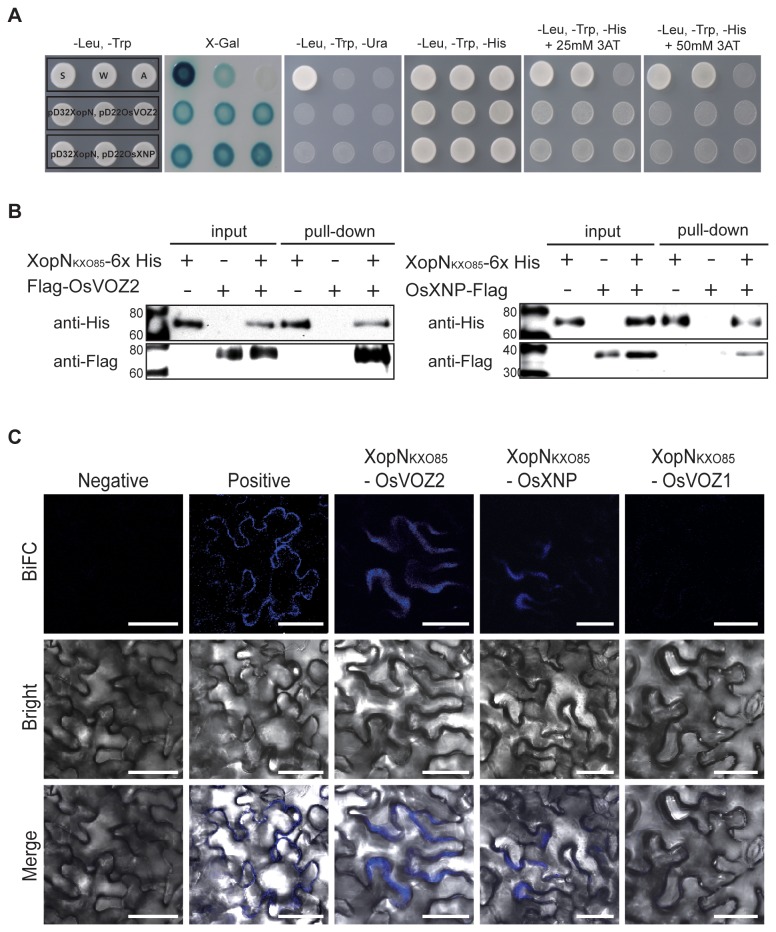
Interactions between XopNKXO85 and OsVOZ2 and OsXNP.
A. Screening for interactors of XopNKXO85 in rice using a yeast two-hybrid system. S (strong: pEXP TM32/Krev1 + pEXP TM22/RalGDS-wt), W (weak: pEXP TM32/Krev1 + pEXP TM22/RalGDS-m1), and A (absent: pEXP TM32/Krev1 + pEXP TM22/RalGDS-m2) indicate the strength of each interaction. Three independent and representative colonies are shown for each bait–prey combination. B. In vivo pull-down analysis of XopNKXO85 and OsVOZ2 (left panel) and XopNKXO85 and OsXNP (right panel). Total proteins from 

N

. benthamiana
 leaves co-expressing XopNKXO85-6× His and Flag-OsVOZ2 or XopNKXO85-6× His and OsXNP-Flag protein were purified by Ni+ affinity chromatography followed by Western blotting using anti-His and anti-Flag antibodies. The expected molecular weights were as follows: XopNKXO85-6× His = 78.7 kDa; Flag-OsVOZ2 = 74.6 kDa; OsXNP-Flag = 40.1 kDa; +, protein expressed; and -, vector control. C. BiFC analysis of XopNKXO85 -OsVOZ2, XopNKXO85 -OsXNP, and XopNKXO85 -OsVOZ1 interactions in 

N

. benthamiana
 leaves. Negative, pDEST-SCYNE(R)GW + pDEST-SCYCE(R)GW; positive, pEXP-SCYNE(R)-Cnx7 + pEXP-SCYCE(R)-Cnx6. Bars = 50 µm.